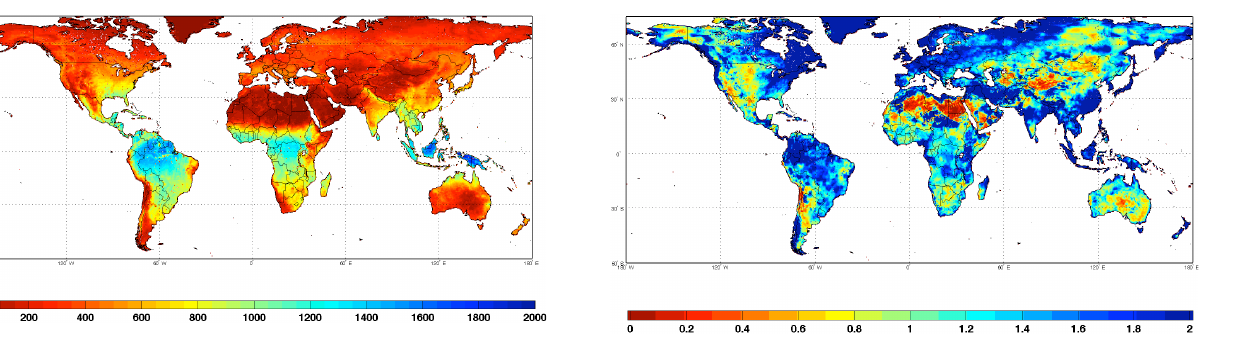
Fig. 4. Map of aridity index for the year 2006, using Global Pre- cipitation Climatology Centre (GPCC) descriptions of rainfall at 0.5 × 0.5 degree and the Global Land-surface Evaporation: Ams- terdam Method (GLEAM) for evapotranspiration. Note that evap- otranspiration rather than potential evapotranspiration values were used in calculating the aridity index for this